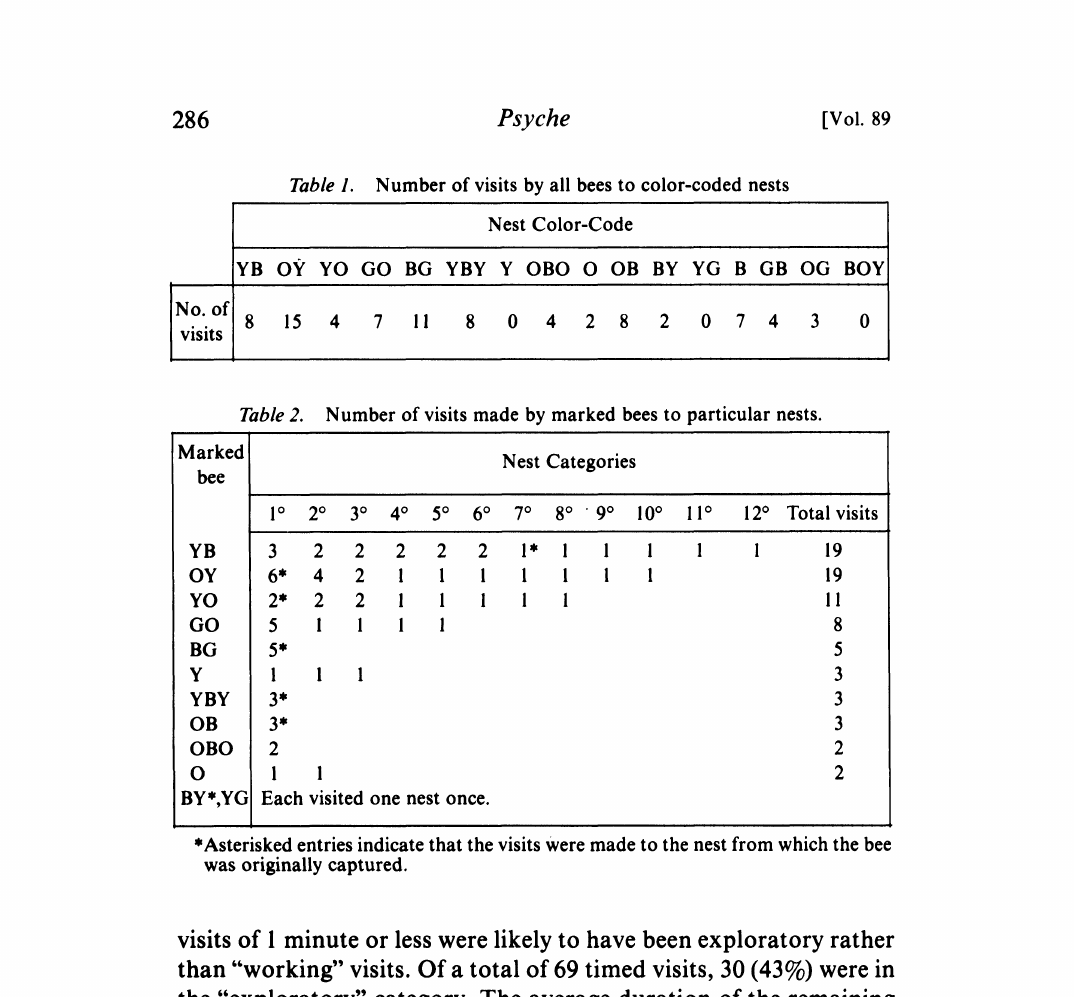
Table 1. Number of visits by all bees to color-coded nests Nest Color-Code